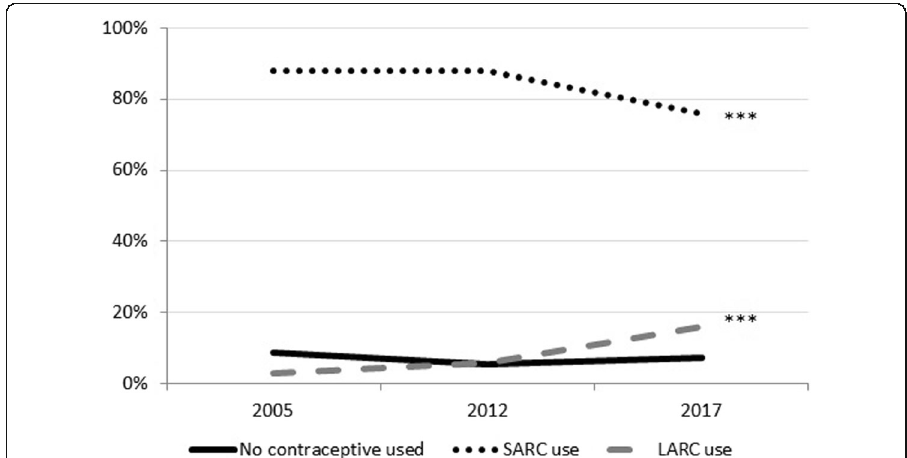
Fig. 1 Trends in contraceptive methods used among Dutch girls aged 12-25 years who experienced sexual intercourse at least once by year of inclusion. Significance indicated; *** p